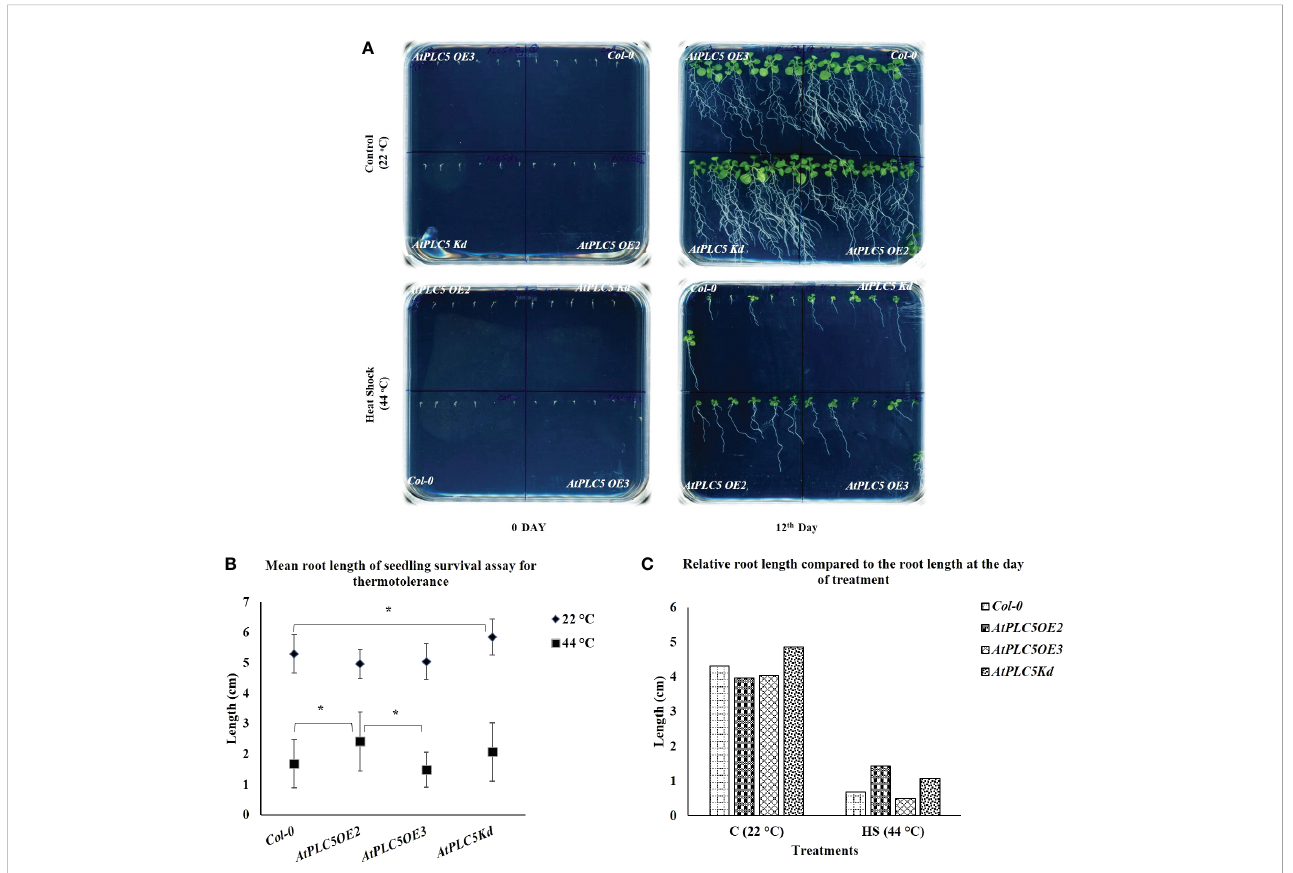
FIGURE 3 Root growth Assay. Square petri plate divided into 4 parts equally. Six seeds of Col-0 and AtPLC5 (OE2, OE3, Kd) mutants placed on each part with an equal distance. Strati fi cation was done for 2 days in cold dark room at 4 °C, then move to 22 °C (16 h L/8 h D) for growth. Three days old seedlings were treated with 0 min (Control) and 36 min at 44 °C (HS) in a water bath. (A) Plates were photographed after 12 days of treatment. (B) Mean was derived from 5 replicates, for each genotype tested containing 6 seedlings each. (C) Relative root length was also determined at the same time. Student's t -test (*P < 0.05) was used to test the level of signi fi cance.